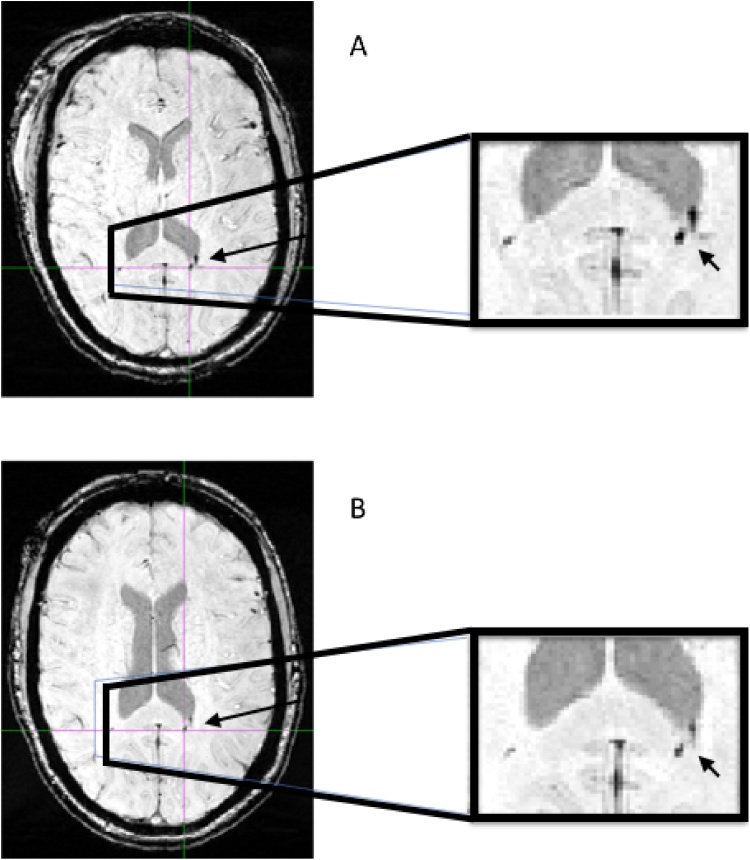
Susceptibility-weighted MR images illustrating change in volume in patient 13.Figure 2 Legend. Representative axial images with magnified views of the splenium of the corpus callosum from patient 13 in whom a decrease in total traumatic cerebral microbleed (TCMB) volume was seen between the first (A) and second (B) scan, 7 days apart. This was accompanied by an increase in GCS and marked improvement in clinical state between the two time-points.